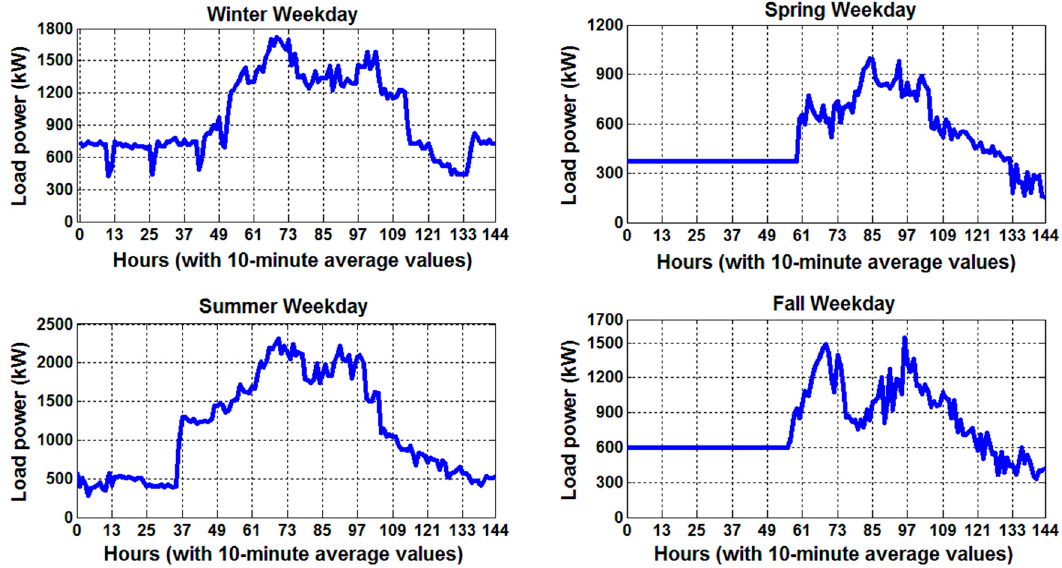
Figure 3. Sample weekday load demand curves, with 10-min average values; for winter weekday